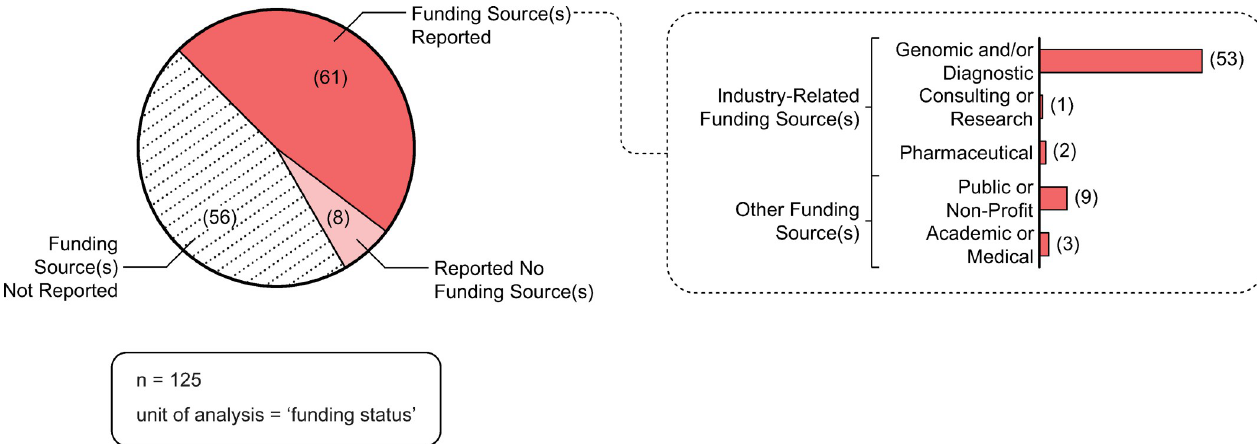
Fig 8. Funding sources. Source: Microsoft Excel was used to facilitate data analysis; Adobe Illustrator was used to facilitate data visualization.